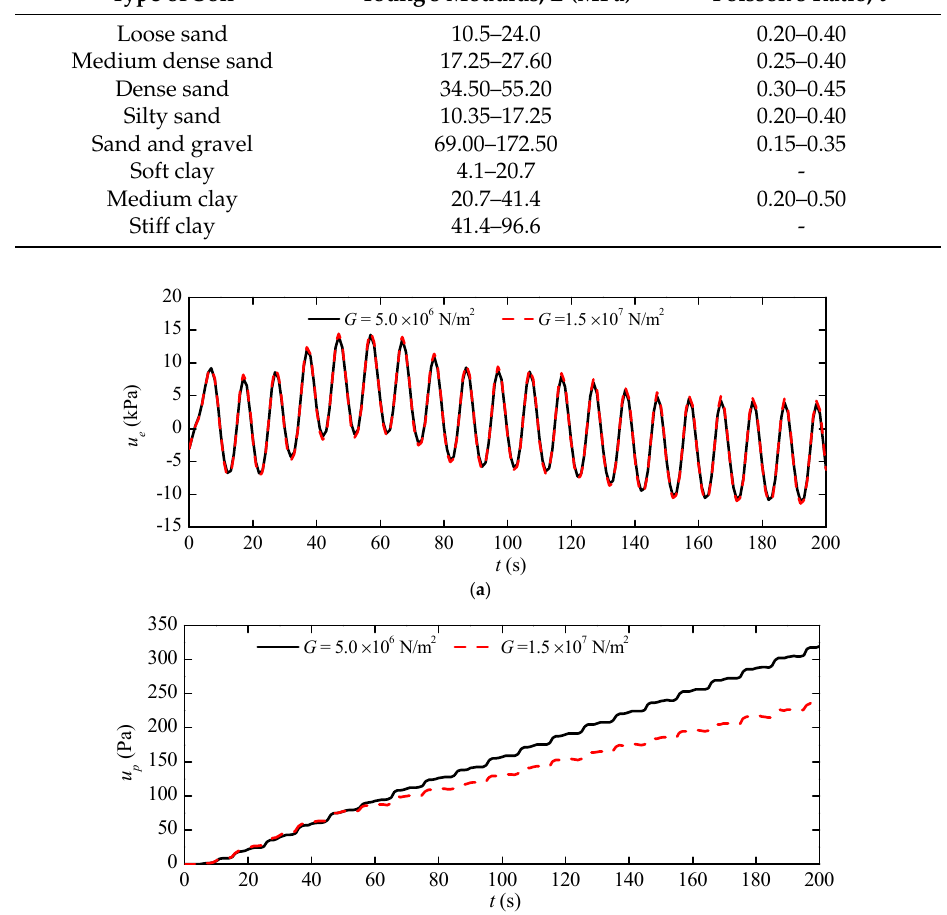
Table 2. Selected elastic constants for soils (adapted from Das, 2007 [36]).